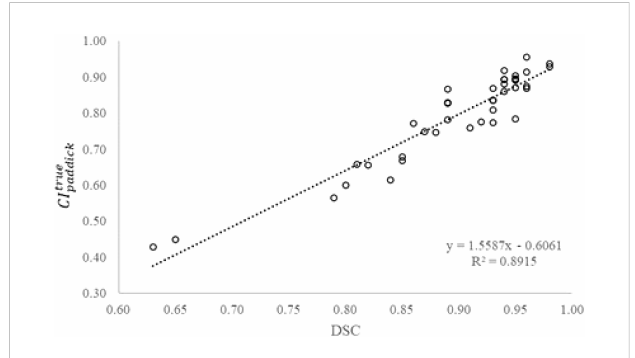
FIGURE 2 True Paddick conformity index ( CI true paddick ) as a function of Dice similarity coef fi cient ( DSC ) of the planning target volume (N=40).